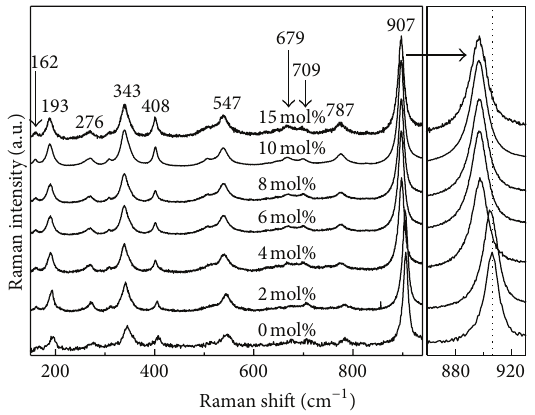
Figure 4: Raman spectra of ZnWO 4 :Er 3+ crystals. The inset shows a zoom on the peak at 907 cm −1